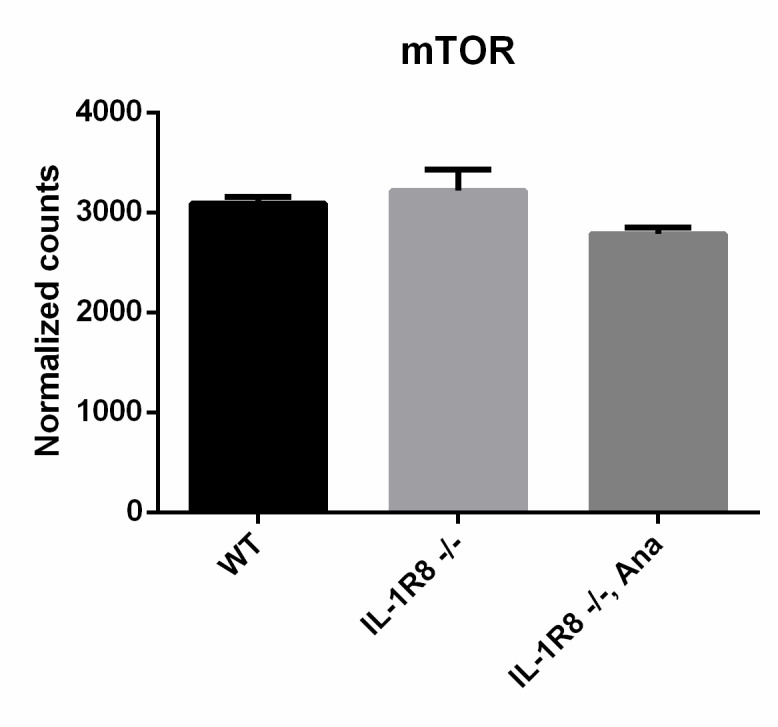
DOI:
http://dx.doi.org/10.7554/eLife.21735.021